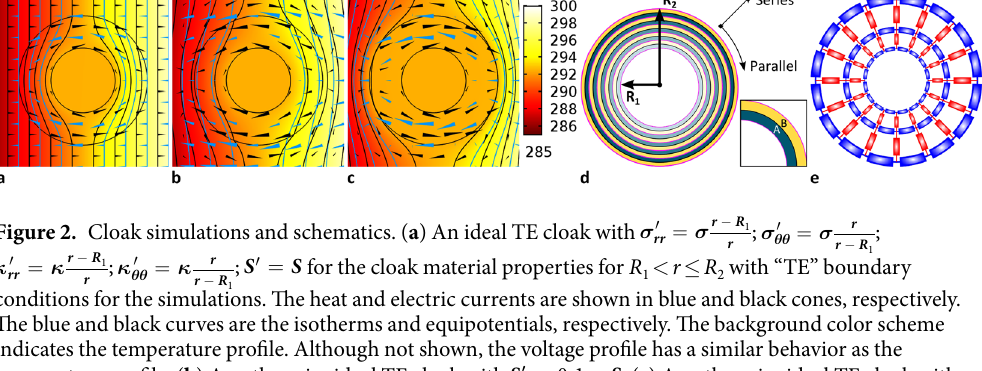
Figure 2. Cloak simulations and schematics. ( a ) An ideal TE cloak with σ σ ′ = − rr r R r R r 1 ; κ κ ′ = κ κ ′ = − ; ′ = S S for the cloak material properties for R 1 < r ≤ R 2 with “TE” boundary rr θθ − r r R 1 conditions for the simulations. The heat and electric currents are shown in blue and black cones, respectively. The blue and black curves are the isotherms and equipotentials, respectively. The background color scheme indicates the temperature profile. Although not shown, the voltage profile has a similar behavior as the temperature profile. ( b ) An otherwise ideal TE cloak with ′ = . ∗ S S 0 1 . ( c ) An otherwise ideal TE cloak with ′ = ∗ S S 10 . ( d ) Concentric bilayers for the circular TE cloak of inner radius R have equal thickness and are made up of two different homogeneous and isotropic materials, denoted as A and B. ( e ) Schematic representation of the electrical conductivity of the layered cloak in terms of a configuration of resistors that are radially in series (red) and azimuthally in parallel (blue) (also denoted in ( d )). Relevant details for the simulations and boundary conditions are shown in